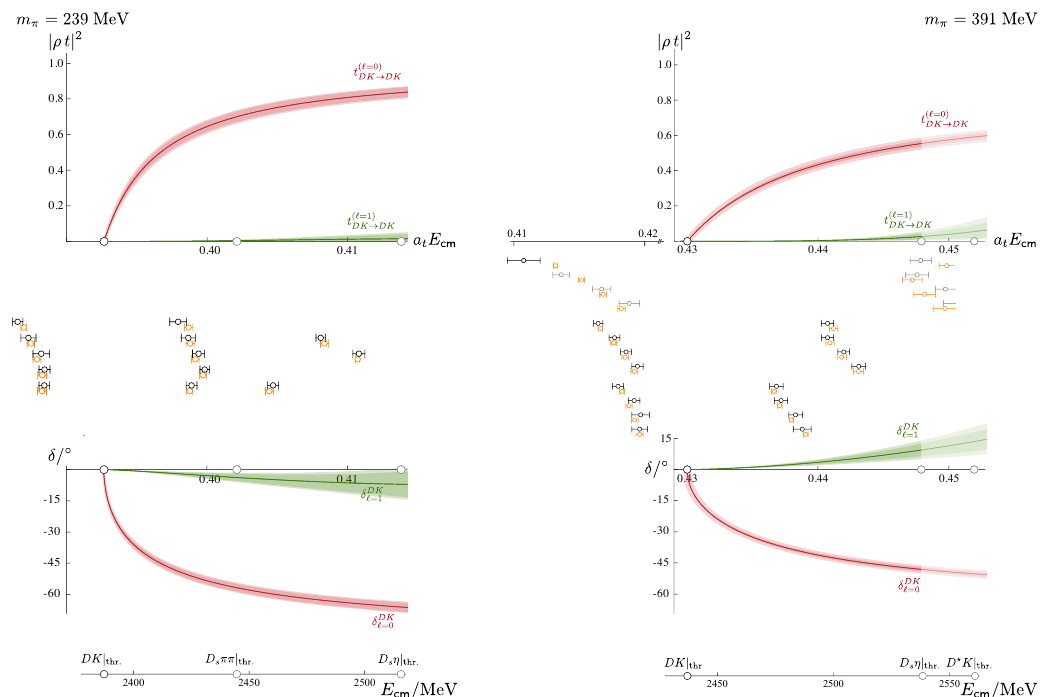
Figure 9 . S and P -wave squared-amplitudes (upper) and scattering phase shifts (lower) for I = 0 DK on the m π = 239 MeV (left) and m π = 391 MeV (right) ensembles. The darker inner bands are the reference parametrisations given in eqs. (5.7) and (5.8) with statistical uncertainties, while the lighter outer bands reflect the uncertainty from varying the D and K meson masses and the anisotropy as described in the text. The black points between the plots show the computed finite- volume energy levels from section 4 used to constrain the amplitudes, grey points are finite-volume energy levels which were not used, and orange points show the energy levels following from the reference